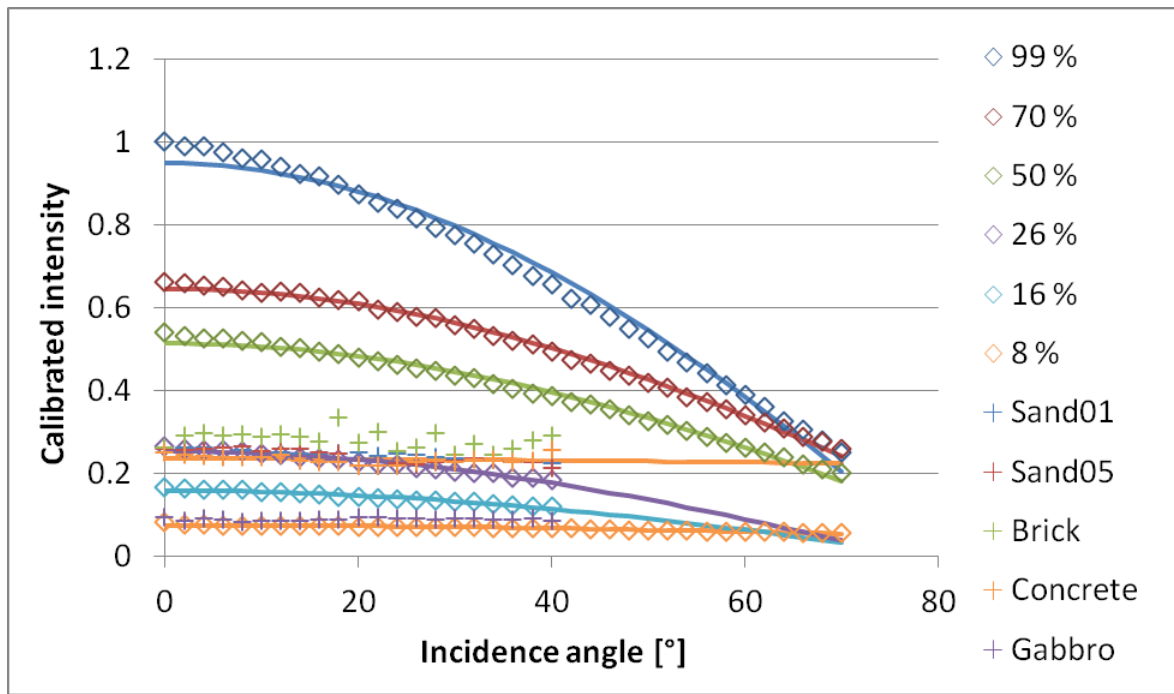
Figure 5. The model in Equation (6) (solid lines) fitted to the experimental incidence angle data. The intensities I( α ) measured with FARO have been divided by the intensity value I(0 ° ) for the 99% Spectralon, measured similarly to the target (the 99% Spectralon itself was normalized to I(0 ° ) = 1 ).